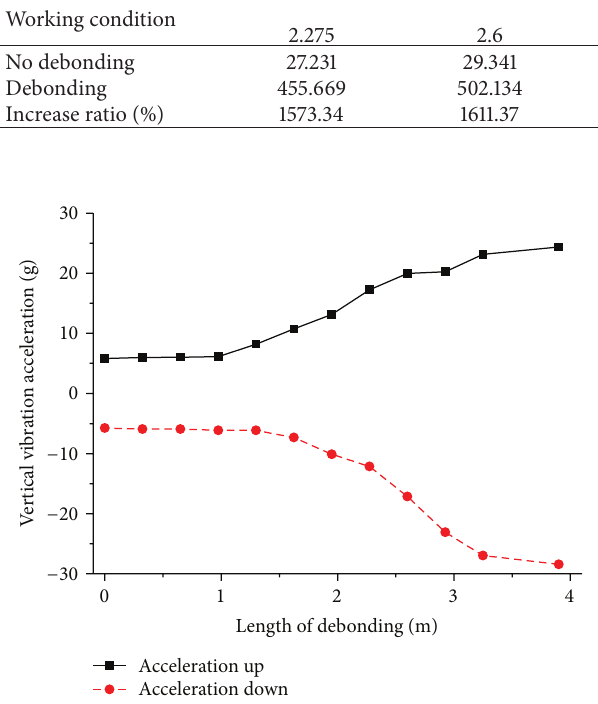
Figure 12: The vertical acceleration of